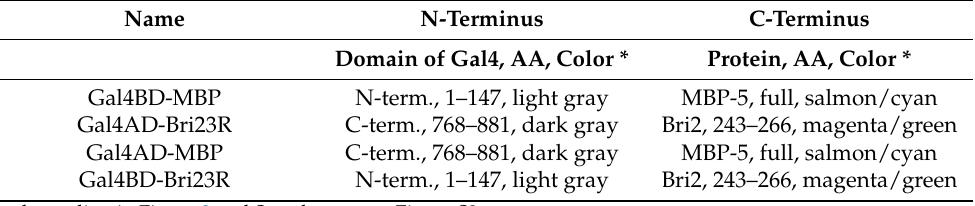
* color coding in Figure 2 and Supplementary Figure